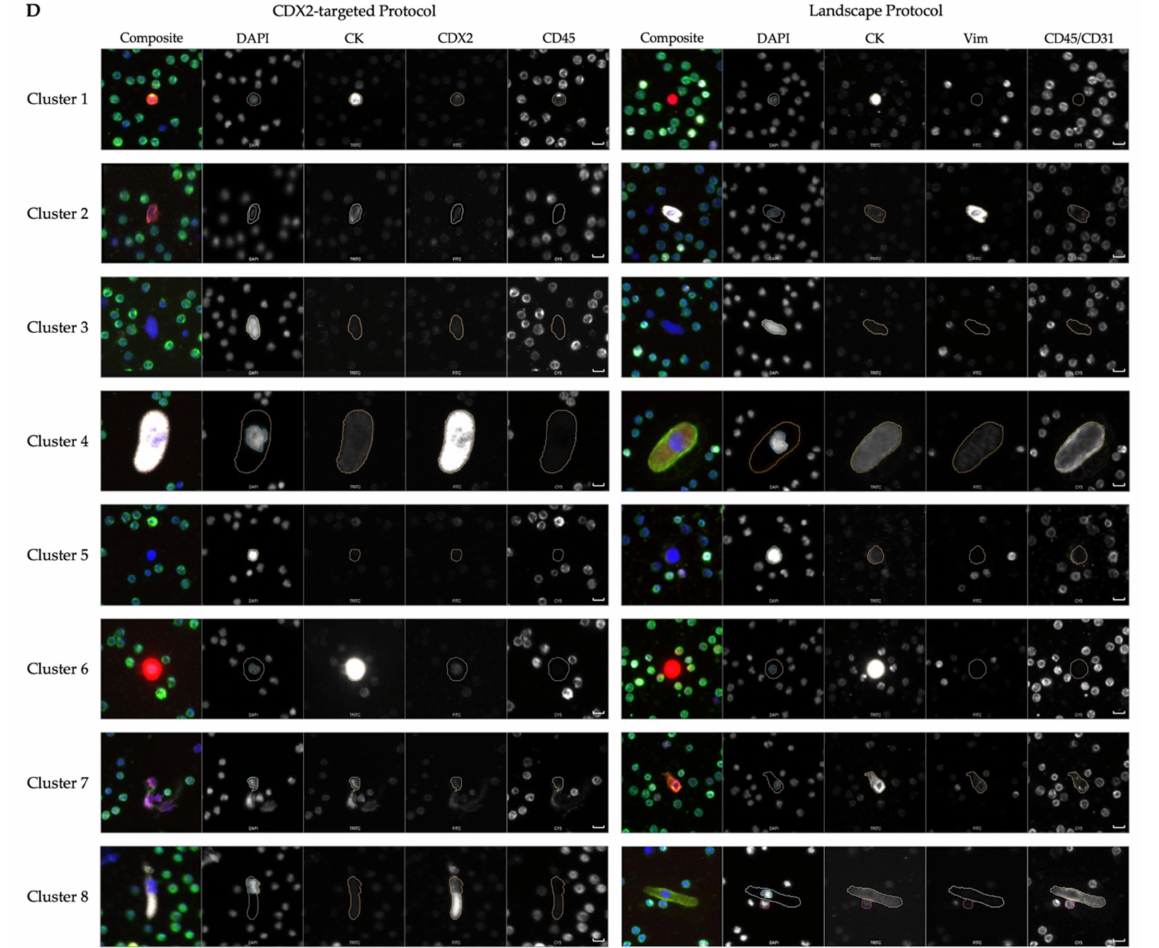
Figure 4. Multi-assay analysis of the Landscape and CDX2-targeted immunofluorescence (IF) assays analyzed by OCULAR. ( A ) Statistically significant ( p ≤ 0.05) rare-event-count correlations across the two IF assays, with the red-to-blue color gradient indicating a negative-to-positive correlation, respectively. ( B ) Cluster occupancy of the rare cells identified by the CDX2-targeted and Landscape stains when using the 8-group hierarchical clustering model. ( C ) t-Stochastic neighbor embedding (t-SNE) plot of the 8 cell clusters comprised of rare cells from both stains, as indicated by the markers’ shape. ( D ) Representative gallery of the 8 clusters with cells from both assays. Each row represents a cluster with a cell from the CDX2-targeted protocol on the left and a cell from the Landscape protocol on the right. Images taken at 100 × magnification. Scale bars represent 100 µ